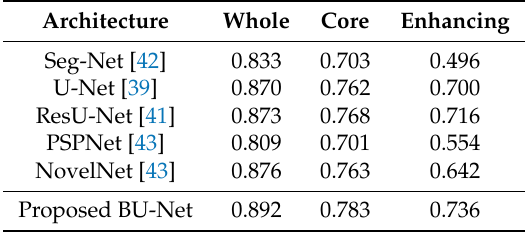
Table 3. Comparison of results with the whole BraTS 2017 dataset (57 MRI